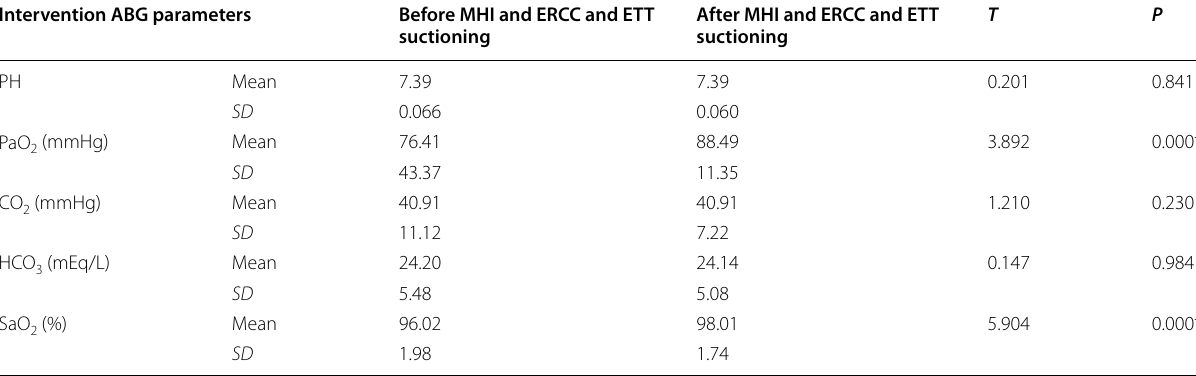
*Statistically significant (if P < 0.05)